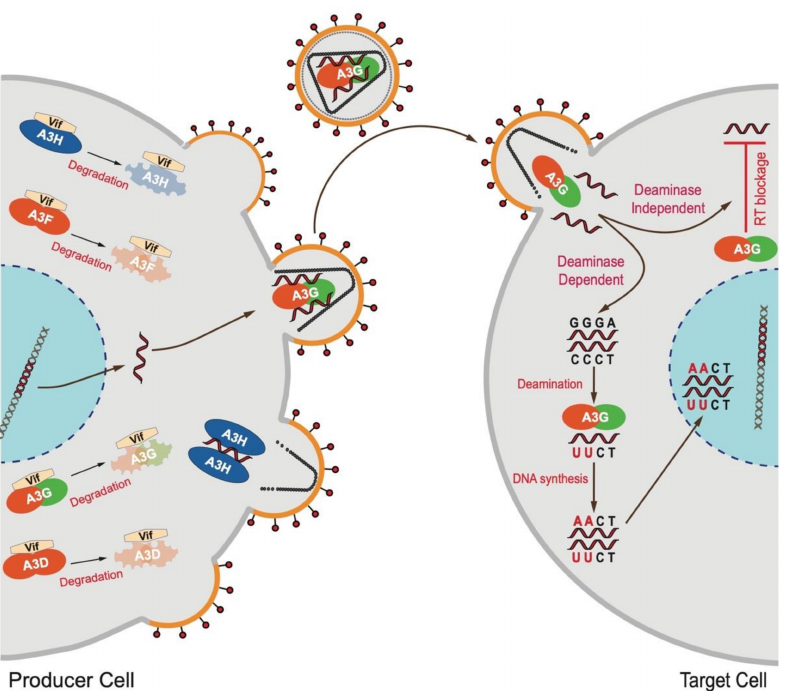
Figure 1. Inhibition of HIV-1 by APOBEC3 enzymes using deaminase-dependent and -independent mechanisms. APOBEC3 enzymes are often counteracted by the HIV-1 Vif protein. Those not counteracted by Vif can package into the budding virions and inhibit viral replication by inflicting C-to-U hypermutation in the HIV-1 cDNA or by deaminase-independent mechanisms such as the physical blockage of HIV-1 reverse